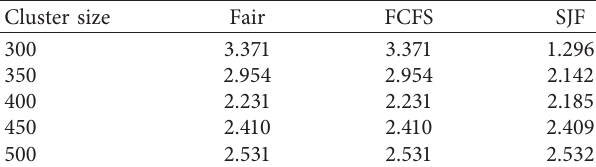
Table 4: The relative delay time of the compared algorithms. Cluster size